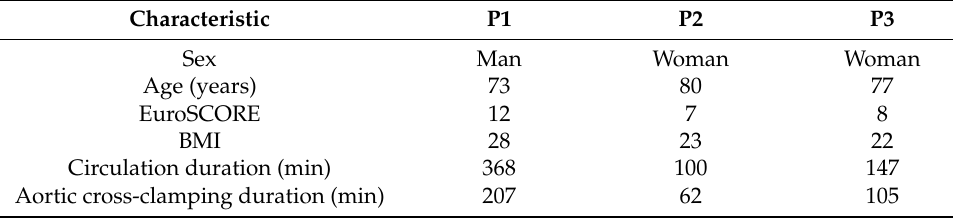
Table 2. Data of patients (P1, P2, and P3) with a diagnosed postoperative